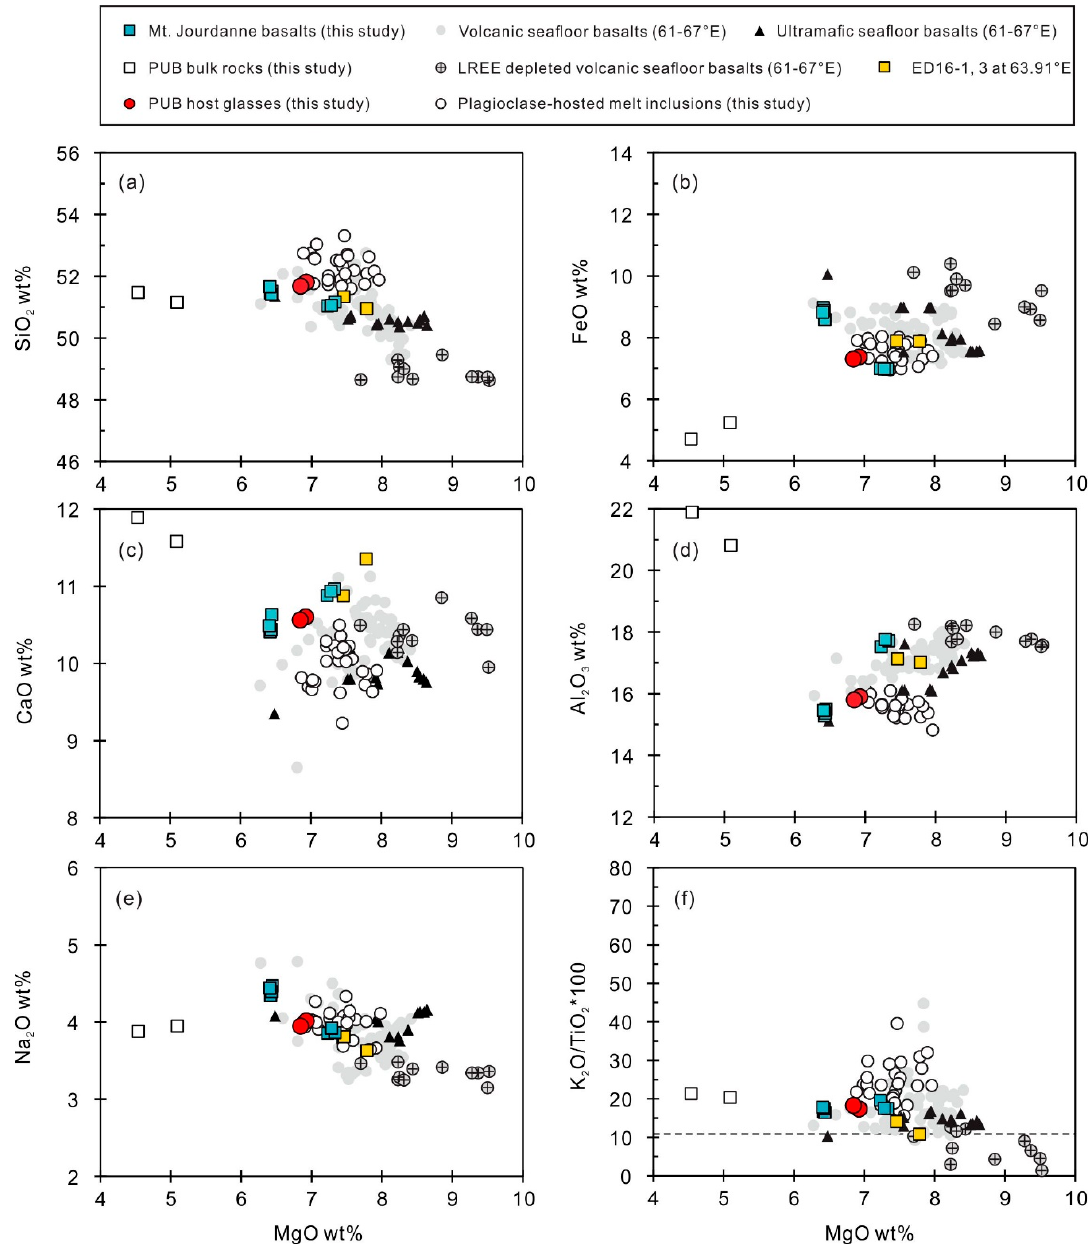
Figure 3. Major element compositions ( a–e ) and K/Ti ratio ( f ) plotted versus MgO for Mount Jourdanne basalts and plagioclase-hosted melt inclusions in PUBs. Basalts from the easternmost part of Southwest Indian Ridge (SWIR) (61–67° E) are plotted for comparison. The 61–67° E basalts are divided into two parts; i.e., basalts from the volcanic seafloor and from the ultramafic seafloors. The volcanic seafloor basalts with depleted light rare earth elements (LREE) are marked with cross in circles (data from Paquet et al. [30]). The horizontal line at K 2 O/TiO 2 × 100 = 11 in ( f ) separates fields for N-MORB (<11) and E-MORB (>11) [45].